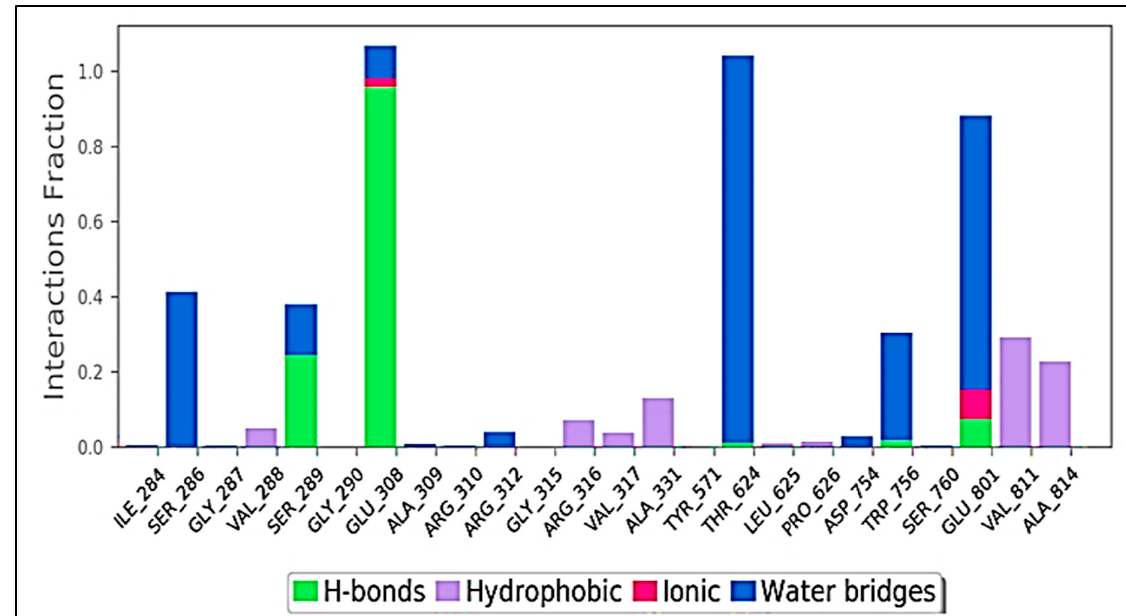
Figure 19. Protein-ligand contact histogram (H-bonds, Hydrophobic, Ionic, Water bridges) of LSD and compound 1 .